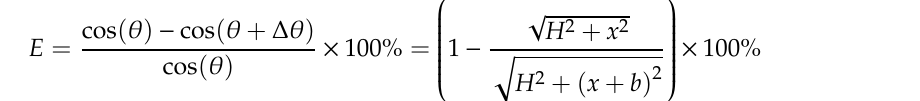
Figure 2. Principle diagram of reflective light detection optical system.